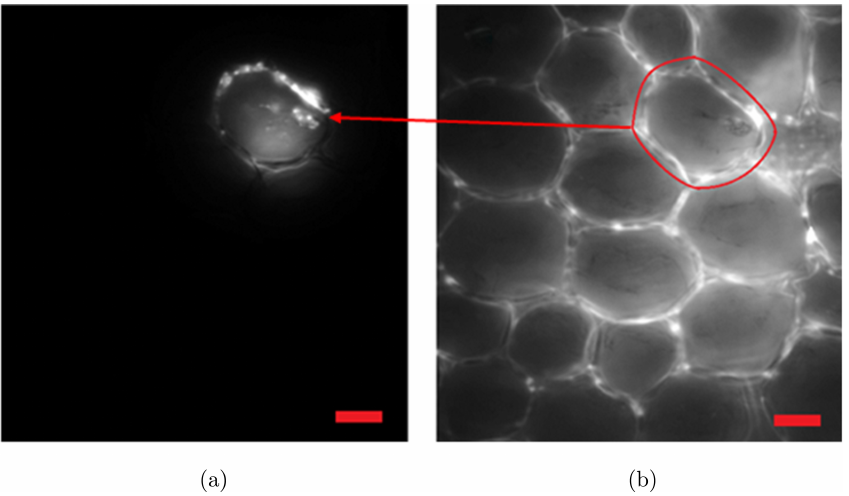
Fig. 4. Two photon °uorescence images of a Convallaria rhizome slide obtained by (a) our system and (b) a traditional TF-MPM. Scale bar is 10 (cid:1) m.